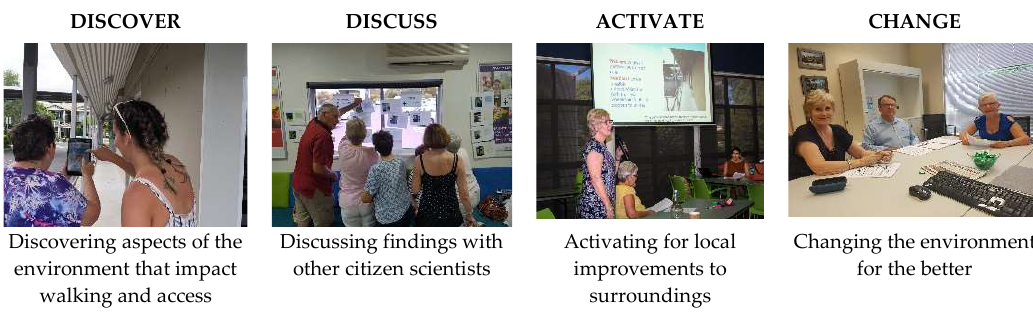
Figure 1. Our Voice Citizen Scientist framework (King et al., 2016) [21]. © Stanford University. All rights reserved.